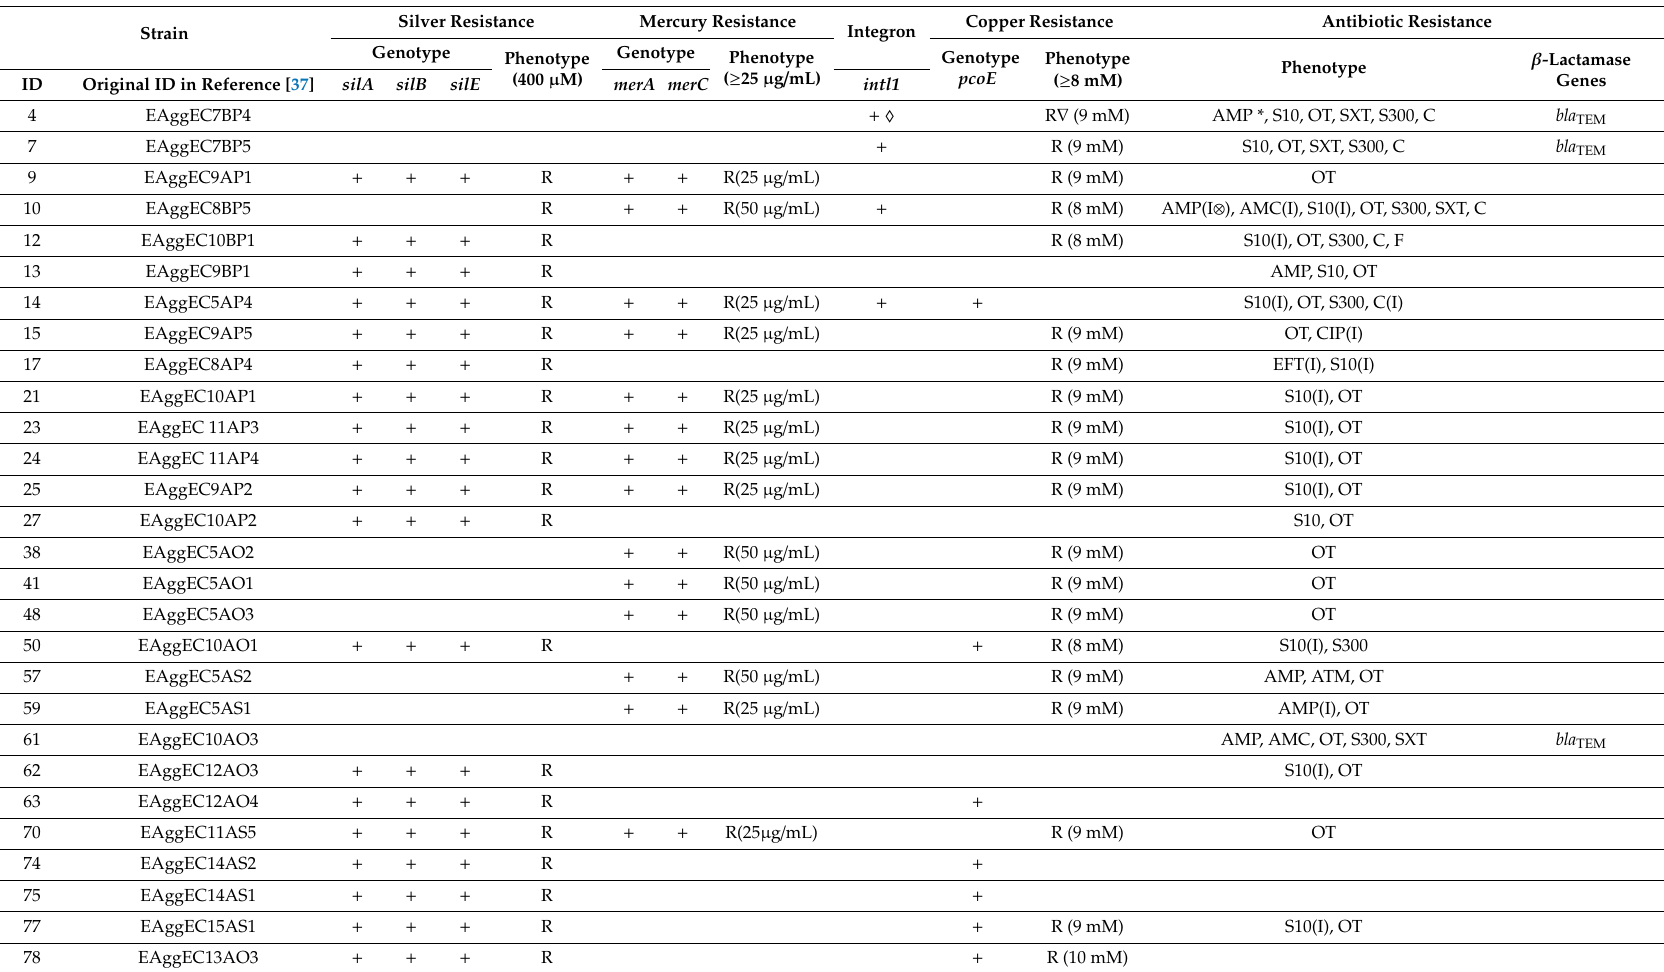
Table 2. Strains with metal resistance genes and / or β - lactamase genes and their phenotypic